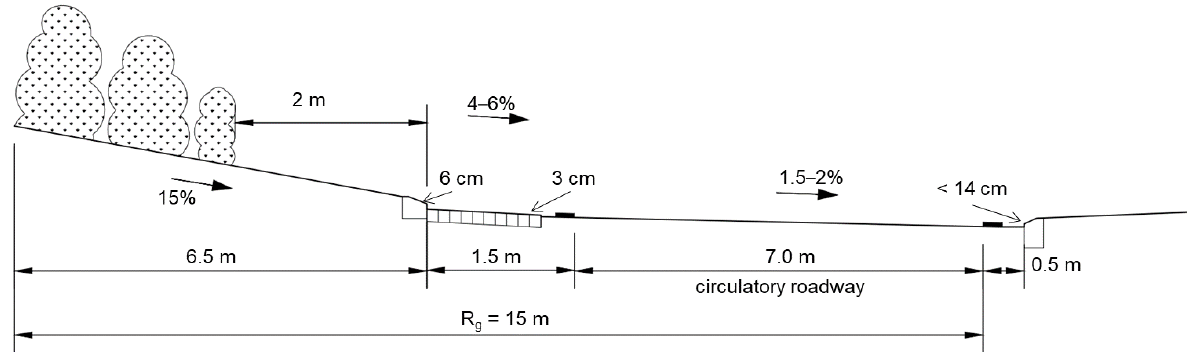
Figure 10. Standard circulatory roadway cross-section for roundabouts with an outer radius of 15 m, according to [6].